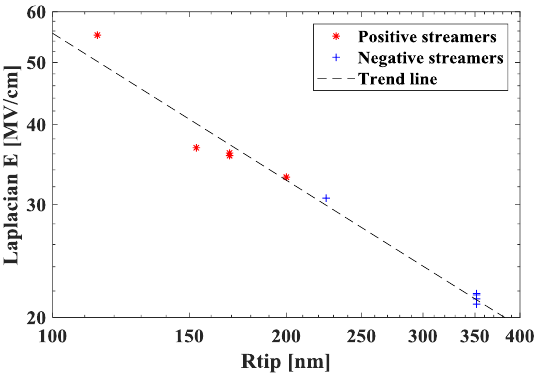
Figure 12. Laplacian electric field at the tip of the needles at 𝑉 50% for mineral oil as a function of 𝑅 𝑡𝑖𝑝